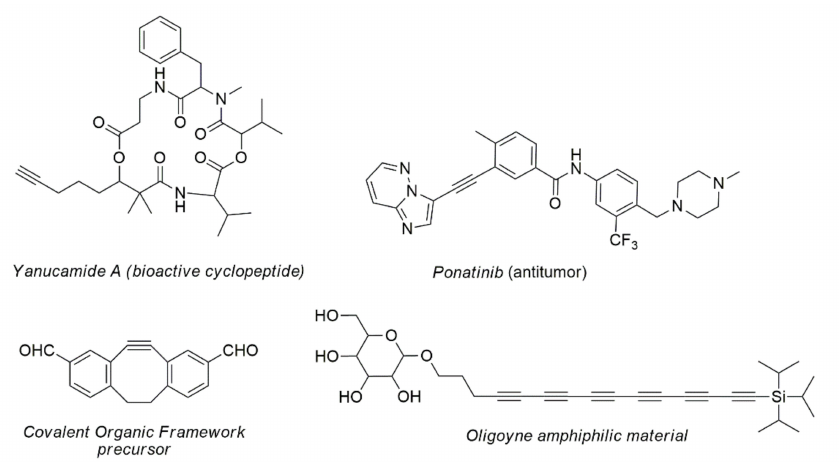
Figure 1. Selected examples of alkyne-containing molecules used as drugs or in material chemistry.